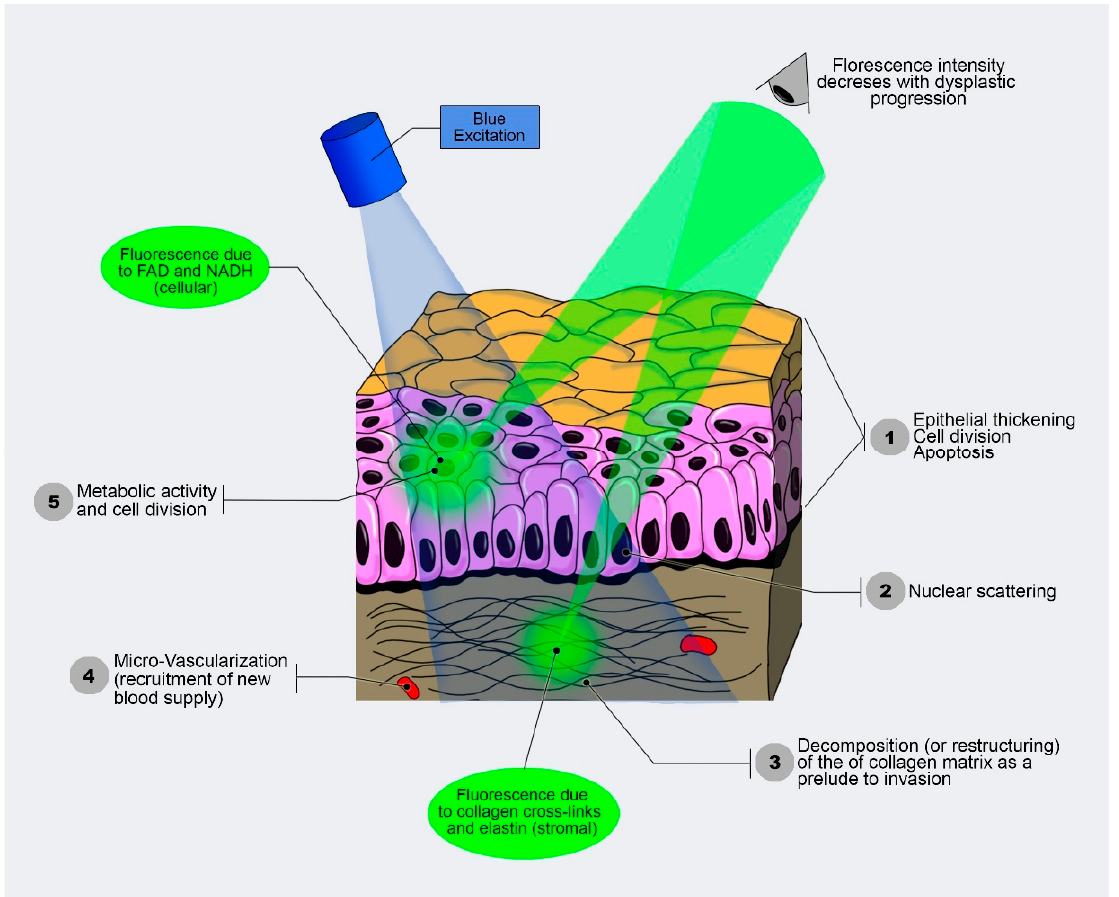
Figure 1. Autofluorescence functioning based on different fluorescence characteristics of the tissues, which illuminates with different intensity (modified from Optical Imaging Lab-screening and diag- nosis with light, Vancouver, Canada). diagnosis with light, Vancouver,